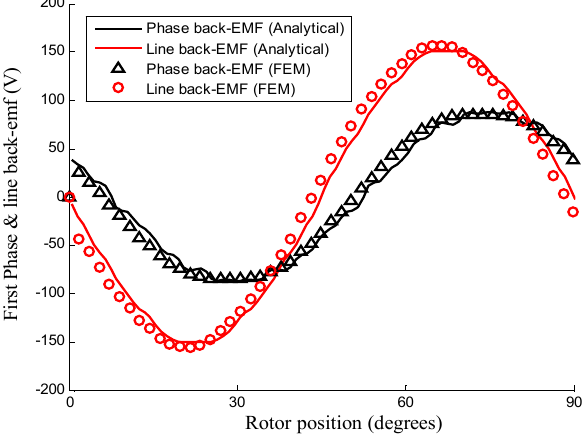
Figure 13. Back-electromotive force (EMF) of the first phase and first line.